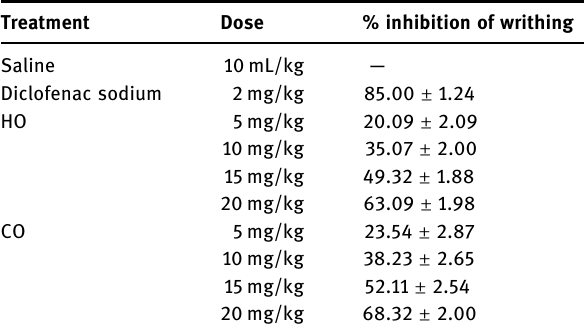
Table 6: Analgesic e ff ect of oil extracts from HO and CO fraction of F. benghalensis Treatment Dose